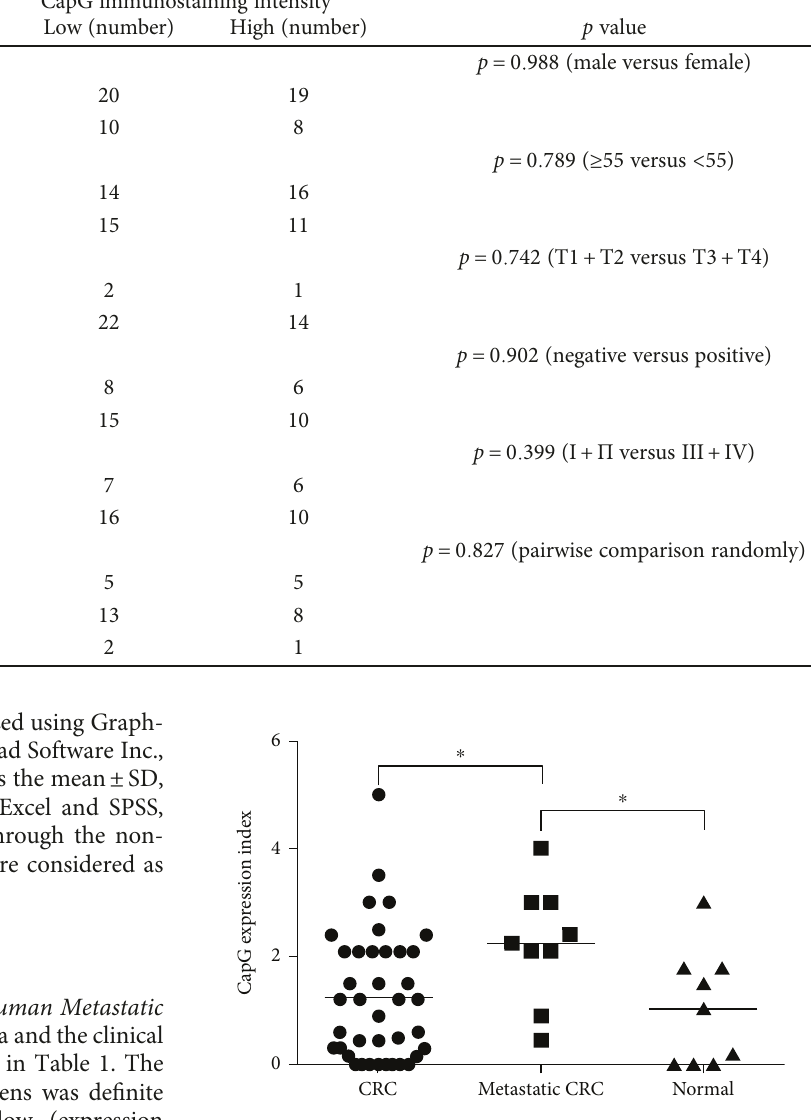
Figure 1: CapG expresses in the human colorectal carcinoma and normal specimens in tissue microarray. A tissue microarray was used to examine the expression of CapG by immunohistochemistry; the expression index of CapG in the human colon tissues was quanti fi ed by a pathologist, and scores of the specimens were also organized depending on the pathologic diagnosis with normal, colorectal carcinoma, and metastatic colorectal carcinoma. ∗ p < 0 05